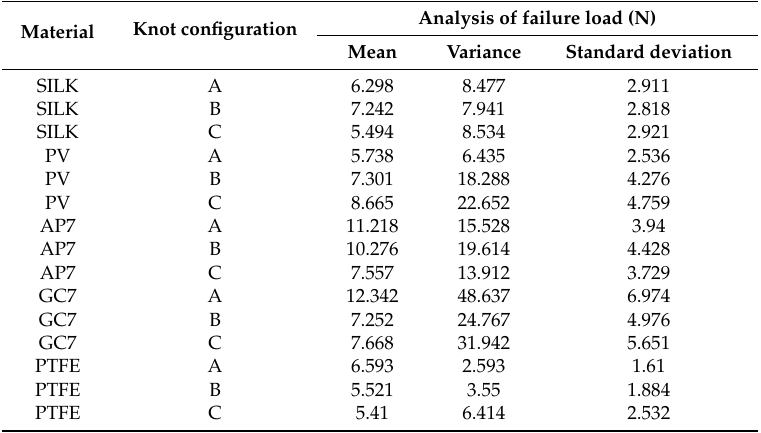
Table 3. Descriptive analysis of sutures failure load at the three knot